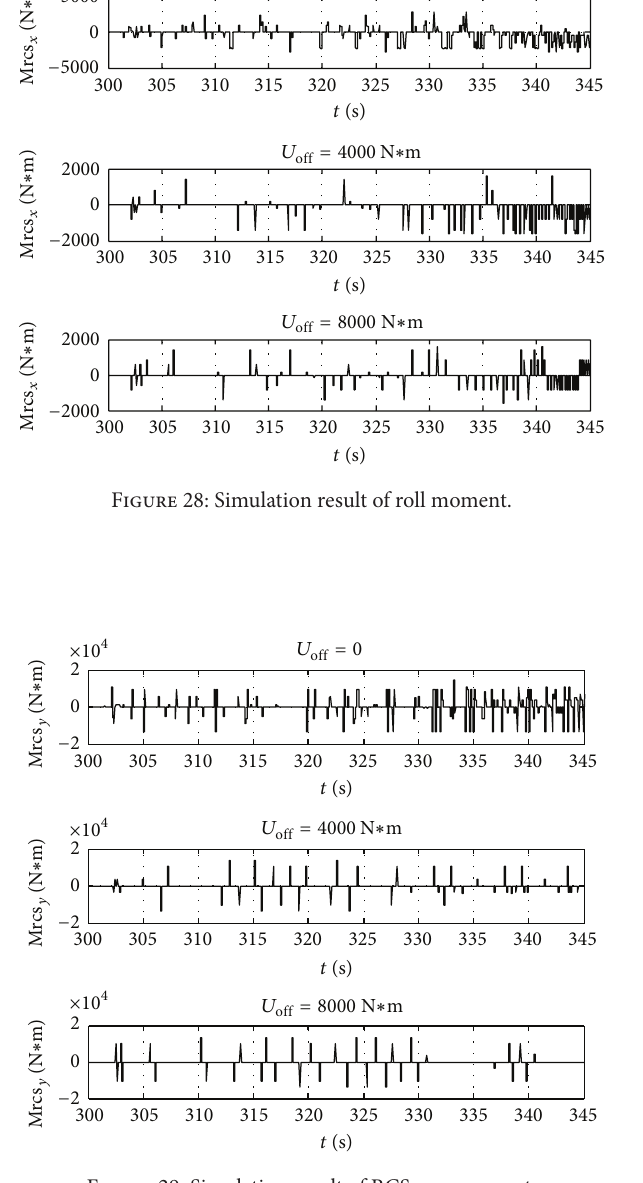
Figure 29: Simulation result of RCS yaw moment.